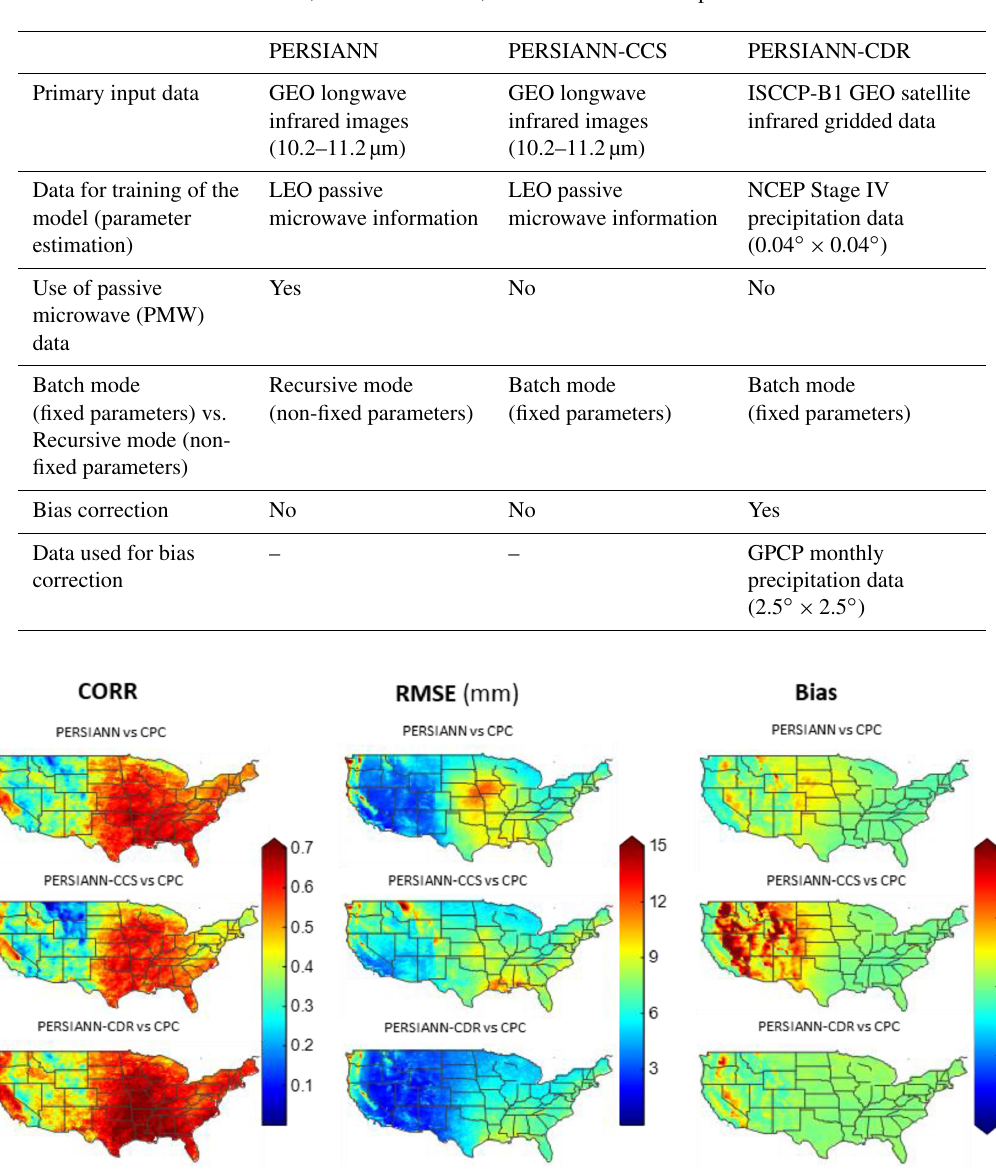
Figure 2. Correlation (CORR), root mean square error (RMSE), and multiplicative bias of PERSIANN, PERSIANN-CCS, and PERSIANN- CDR against CPC for the period (2003–2015) over the